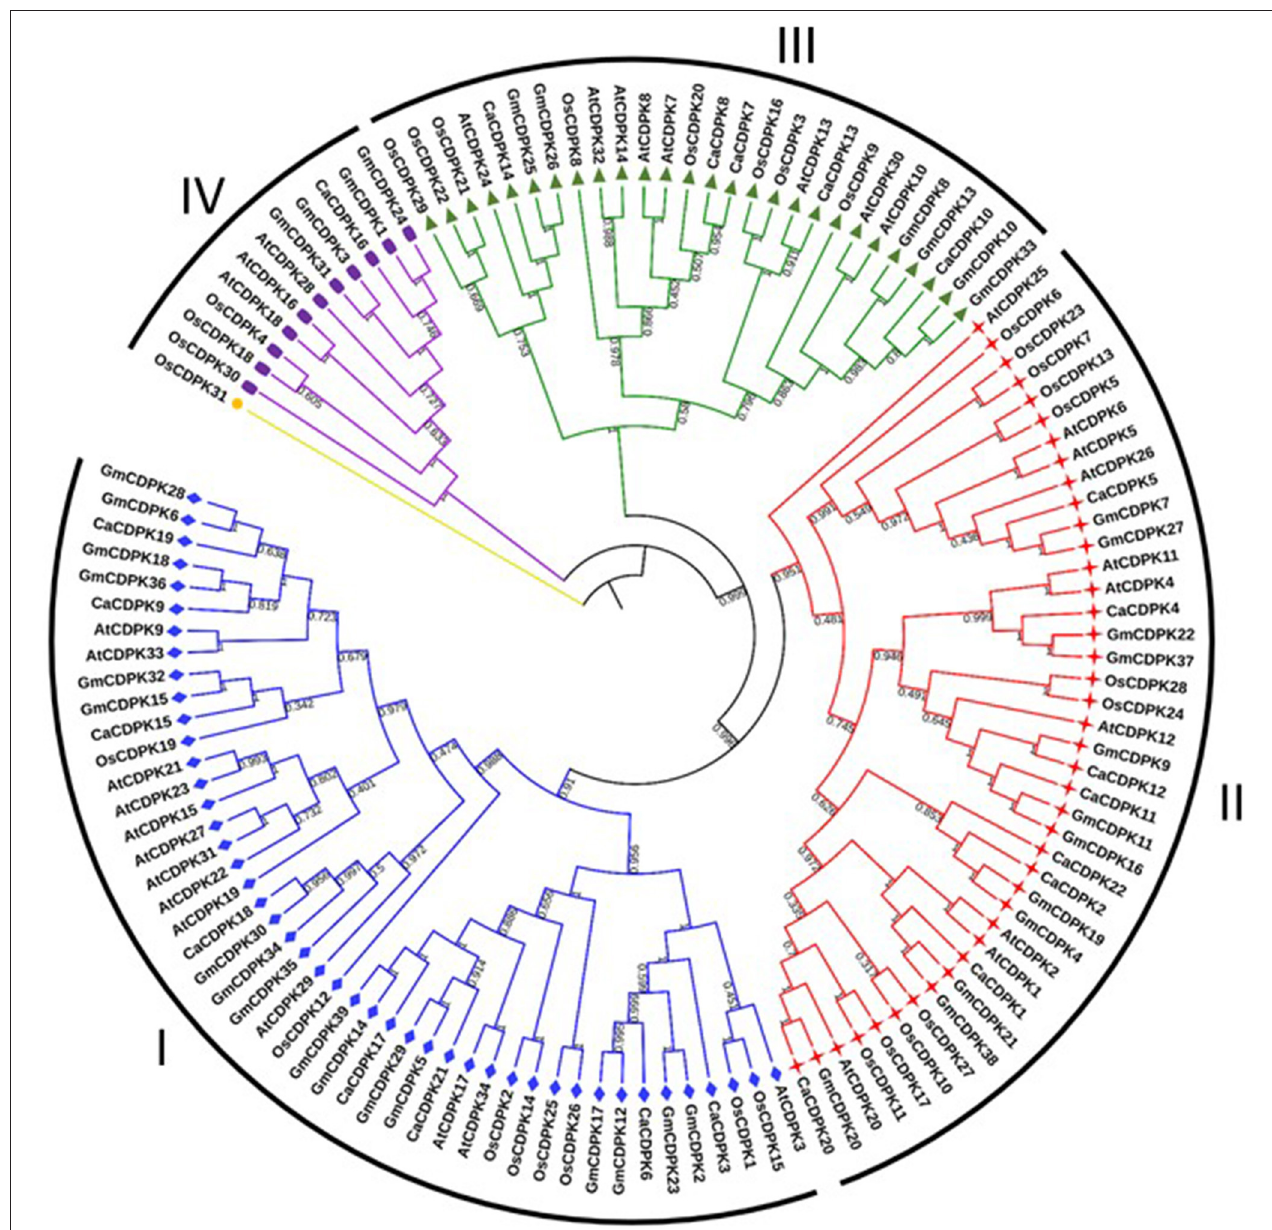
FIGURE 2 | Phylogenetic relationship among CDPKs from different plants. An un-rooted neighbor-joining phylogenetic tree was constructed from the CDPK protein sequences of Arabidopsis thaliana , rice, soybean, and chickpea. All the CDPKs could be divided into four groups; I- IV. Numbers above the nodes represent bootstrap values calculated from 1,000